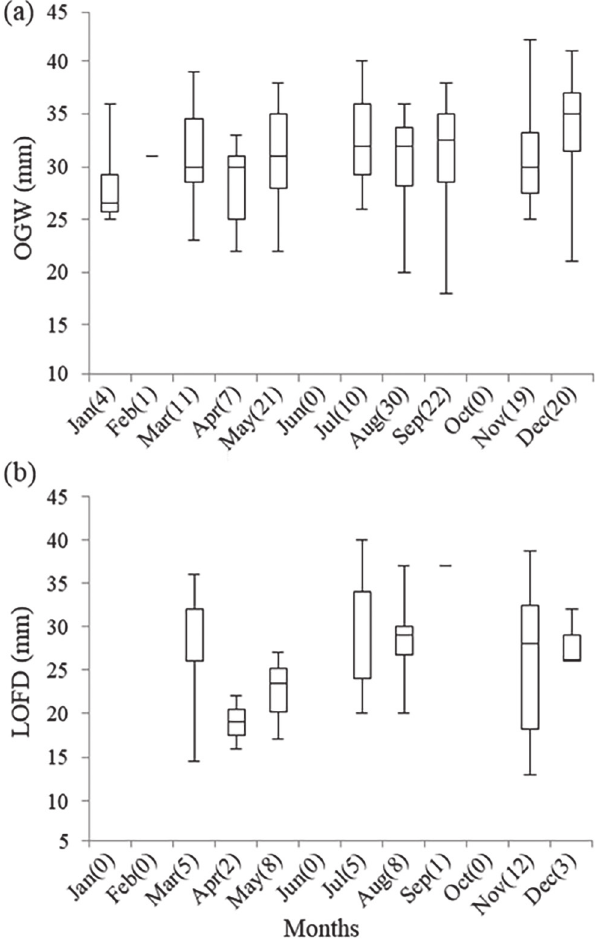
Fig. 8. Seasonal variation in a. oviductal gland width (OGW) and b. diameter of the largest ovarian follicle (LOFD) in Atlantoraja cyclophora females. The number of samples analyzed is between parentheses. The boxes represent the interquartile range between Q1 and Q3 with the 50% of data, the central line represents the median value and whiskers extend to the maximum and minimum